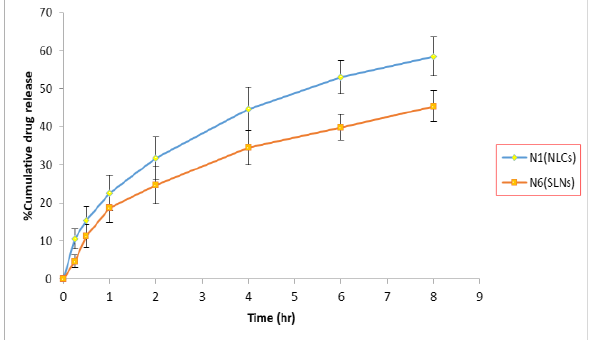
Figure 1. Cumulative release profile of formula N1 (NLCs) and formula N6 (SLNs), mean values± standard